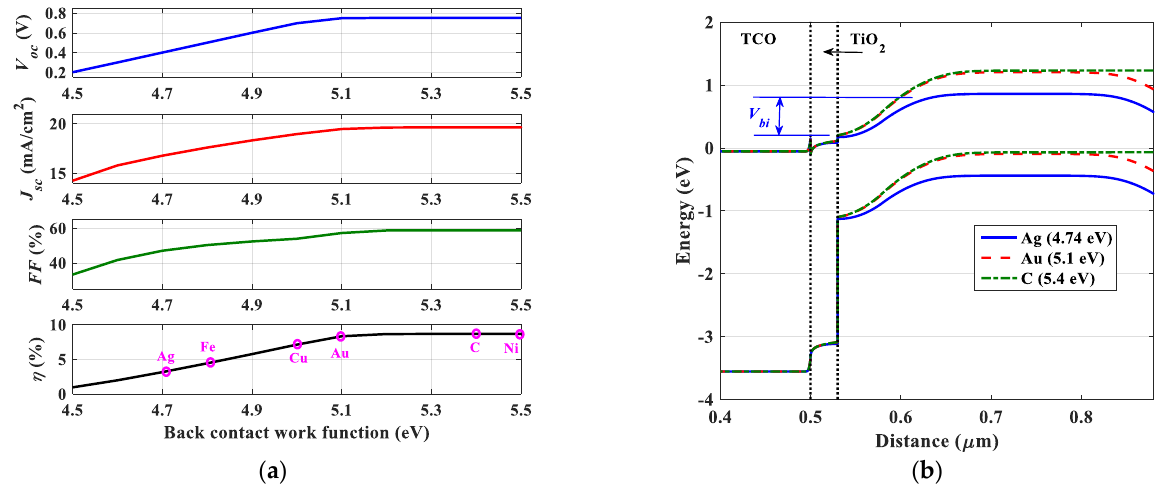
Figure 14. Impact of different metal contacts with distinct work function values on the HTL-free configuration photovoltaic parameters. ( a ) Photovoltaic parameters, and ( b ) energy band diagram drawn at the short-circuit condition for three different metal electrodes (work function values are also indicated).